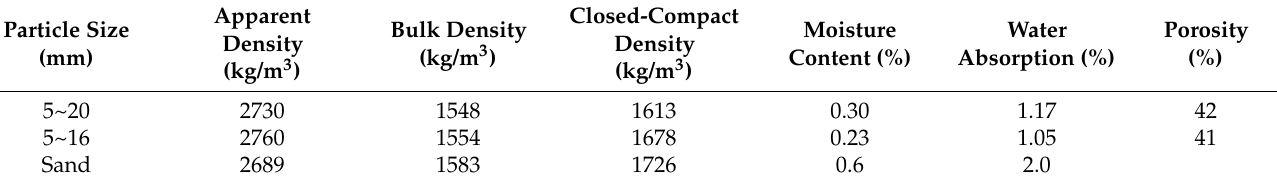
Table 5. Physical properties of crushed limestone and manufactured